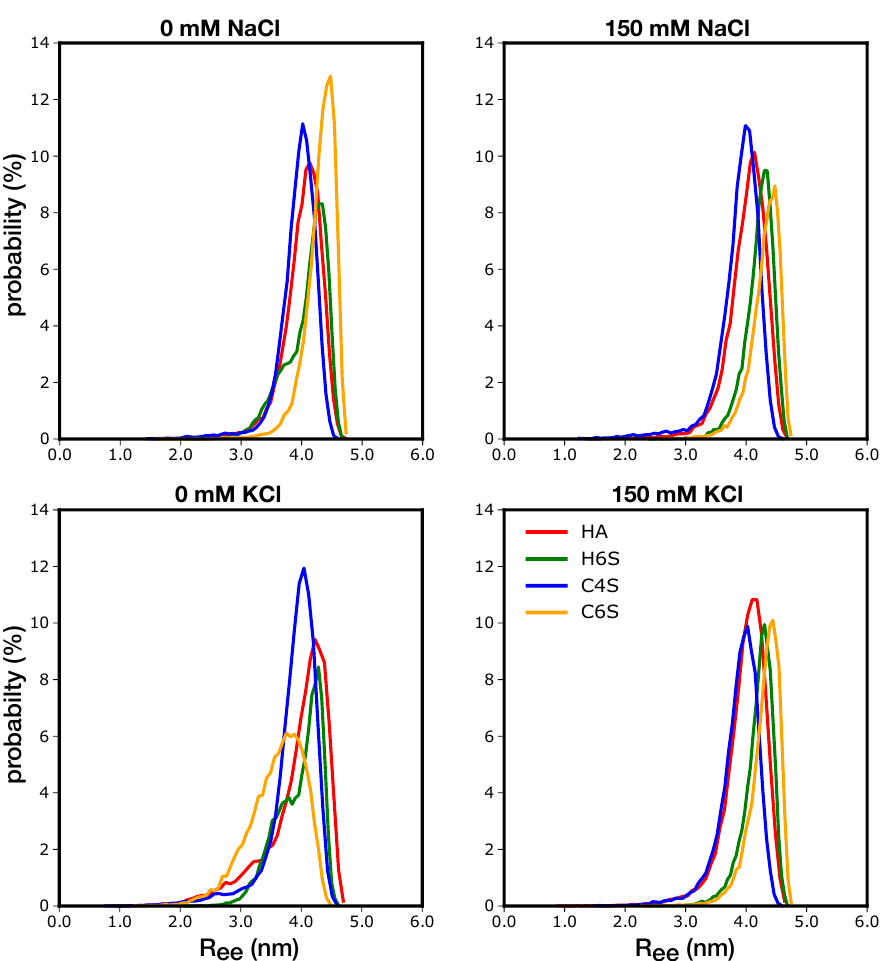
Figure 5. Distribution of the end-to-end distance ( R ee ) for the different GAGs (see the color key) at the 0 mM ( left ) and 150 mM ( right ) salt concentrations (see the label above each